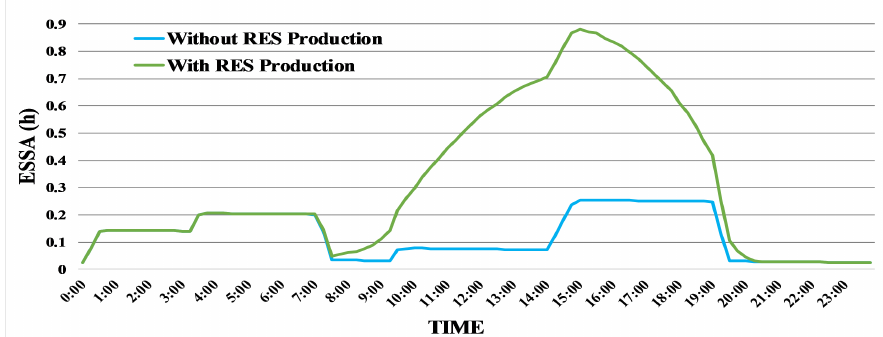
Figure 5. Energy Storage System (ESS) Autonomy on the 23 August